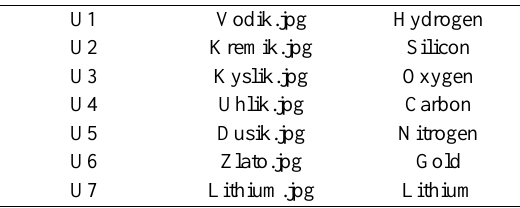
Table 1. The list of the tasks, solving by students